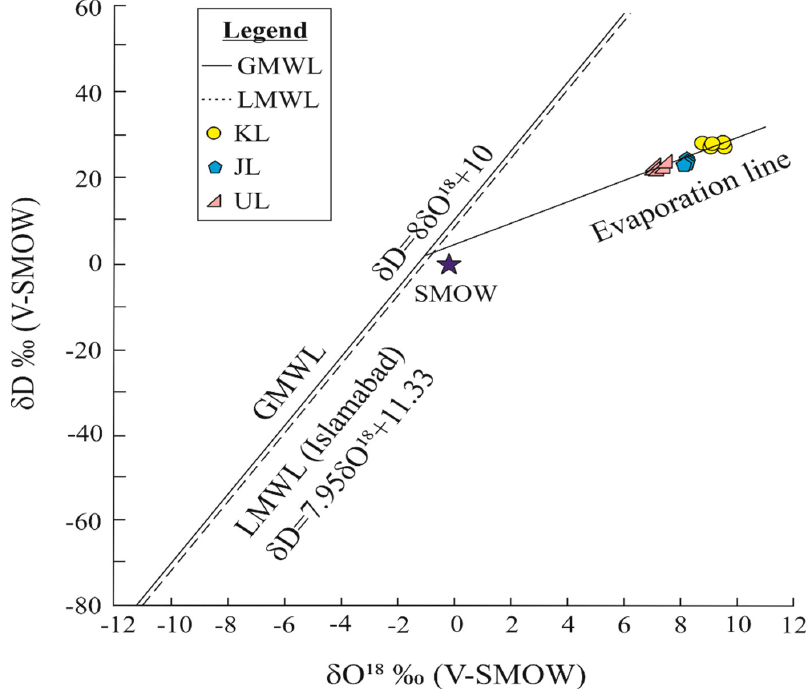
Figure 8. Classical water δ 18 O vs. δ D diagram. The GMWL is taken from [70], LMWL from [71] and the evaporation line from [1,70]. the evaporation line from